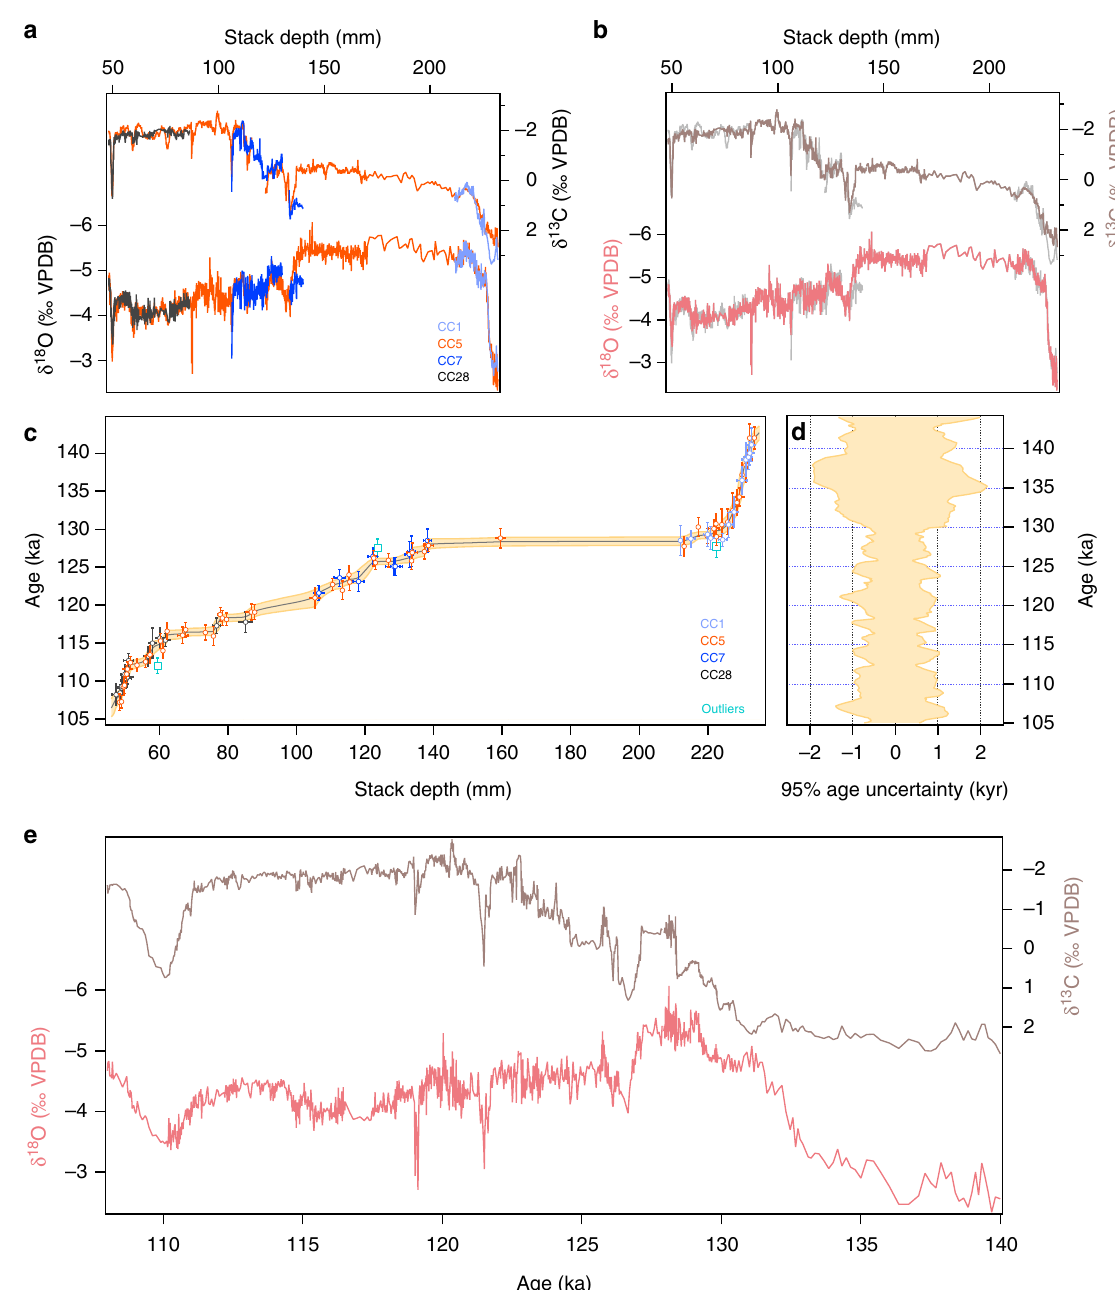
Fig. 2 Antro del Corchia speleothem stack and age model. a Individual Corchia speleothem δ 13 C and δ 18 O series tuned to a common (stack) depth scale. b The composite Corchia speleothem δ 13 C (brown) and δ 18 O (pink) series plotted on the stack depth scale. The grey background curves are the individual series from a . c The Corchia stack age model based on 90 U – Th ages (colour coded by speleothem). The cyan symbols are three outlying ages rejected from the modelling (see Methods). The age model is based on the remaining 87 ages. The pale yellow envelope represents the 95% model-age uncertainties. Horizontal bars represent 100% sampling errors, while the vertical errors bars are the 95% uncertainties on the individual U – Th age determinations. d The 95% age-uncertainty envelope vs. age derived from the age model shown in c . e The fi nal composite Corchia δ 18 O and d δ 13 C time series based on the age model shown in